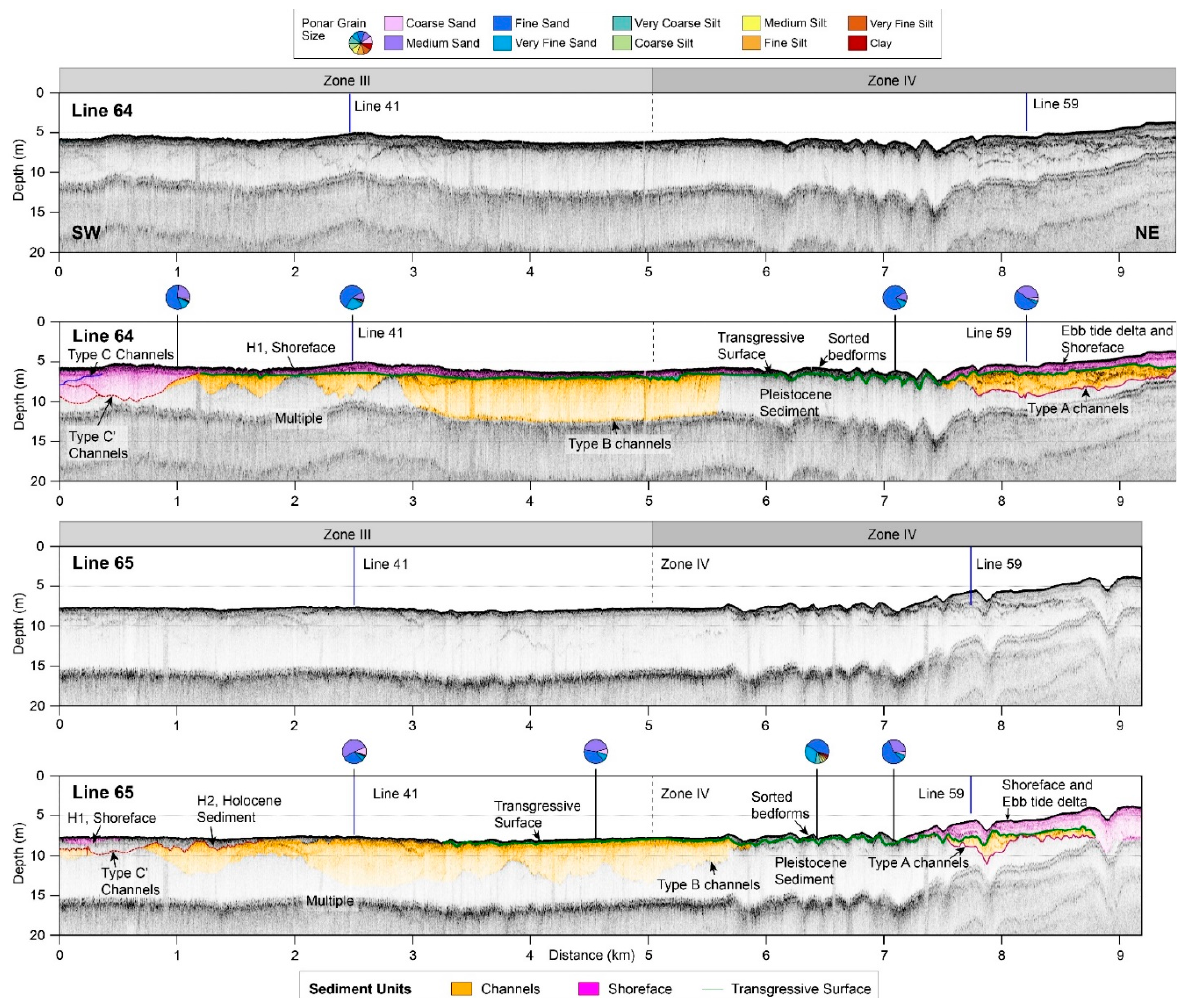
Figure 10. Nearshore strike profile 64 and seaward line 65 within the eastern geomorphic zones III and IV highlight along-margin variability in shoreface units, type B channels, and ebb tide delta deposits. Solid black lines show the location of surficial sediment grabs and grain size composition is shown by colored wedges. Blue vertical lines indicate intersecting dip profiles shown in Figure 8C,D. Profile locations are shown in Figure 1.